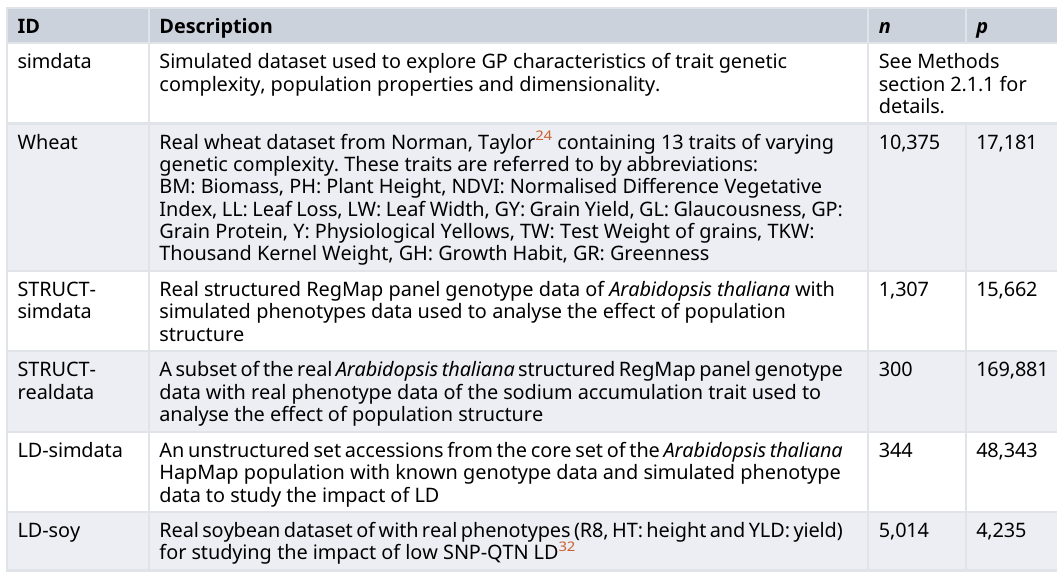
See Methods section 2.1.1 for details.